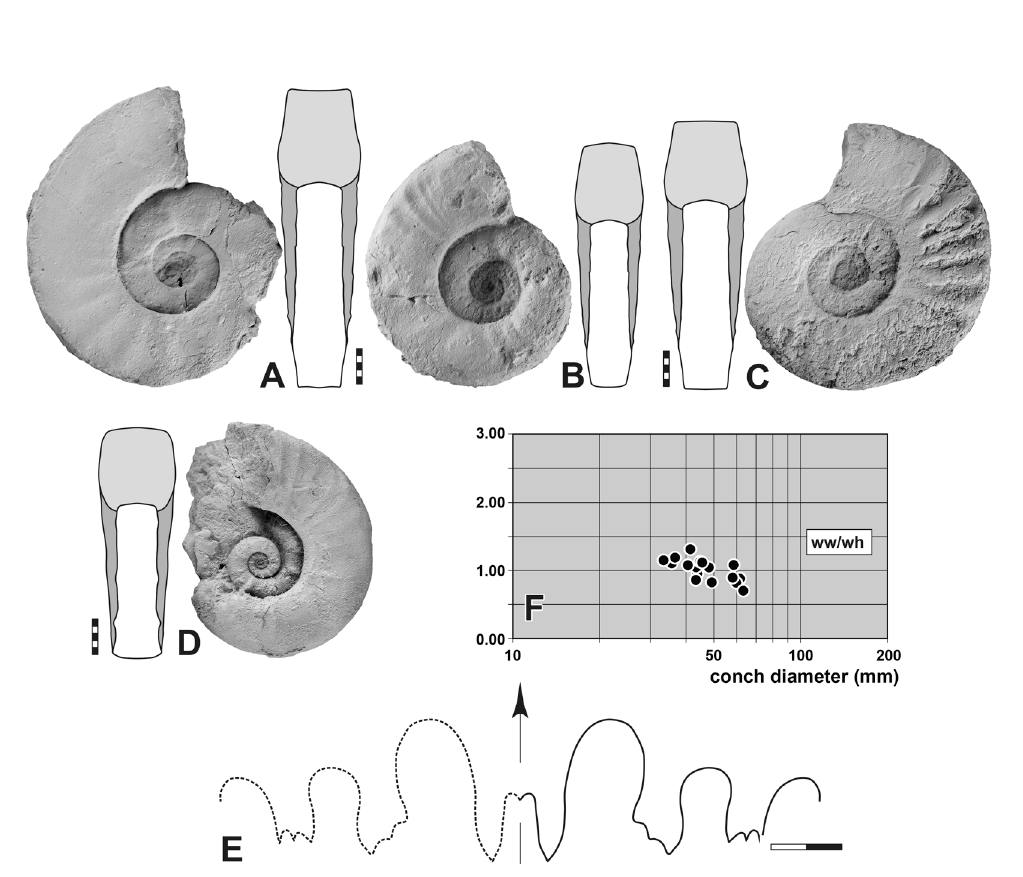
Fig. 59. Abichites stoyanowi (Kiparisova, 1947). A . Lateral and dorsal view, specimen MB.C.30078, section G, -0.40 m. B . Lateral and dorsal view, specimen MB.C.30081, section G, -0.05 m. C . Lateral and dorsal view, specimen MB.C.30079, section F, -0.75 m. D . Lateral and dorsal view, specimen MB.C.30074, section C, -0.50 m. E . Suture line, specimen MB.C.30078, at 7.2 mm ww, 7.4 mm wh. F . Whorl profile proportions. Abbreviations: see Material and methods. Scale bar units = 1 mm.